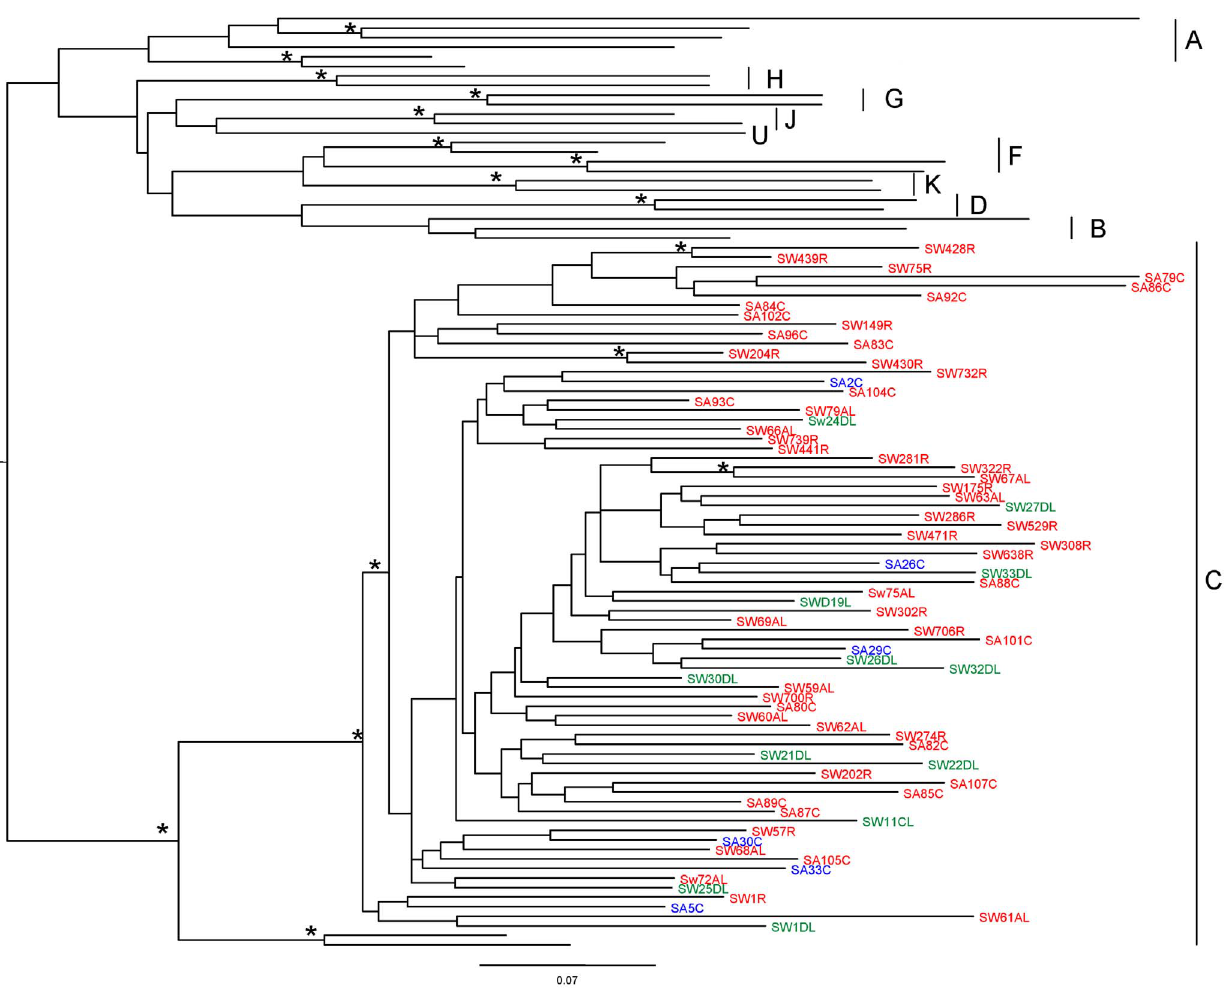
Figure 1. V3–V5 phylogenetic tree of HIV-1 strains from 72 HIV-1-infected patients in South Africa and Swaziland. Tree was rooted by using the midpoint rooting method. Scale bar at the bottom indicates 7% nucleotide substitutions per site. The asterisk along a branch represents the bootstrap value (significant statistical support) . 70% and p , 0.001 in the zero-branch-length test. Years of collection of samples are color- highlighted: 2005 in blue, 2006 in red and 2007 in green. Country where sample collection was performed: SW = Swaziland; SA = South Africa.